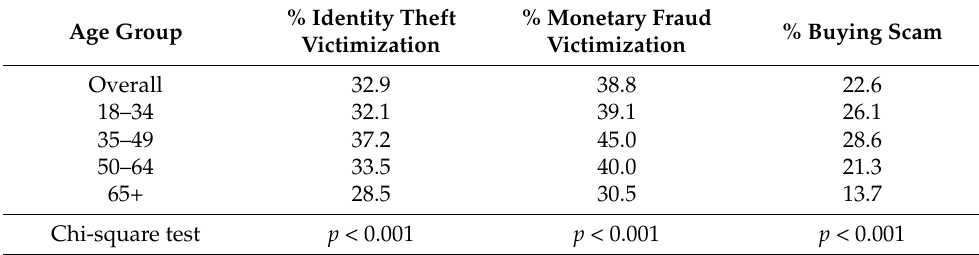
Table 3. Percentage of victimization of different fraud types in weighted sample. Age Group